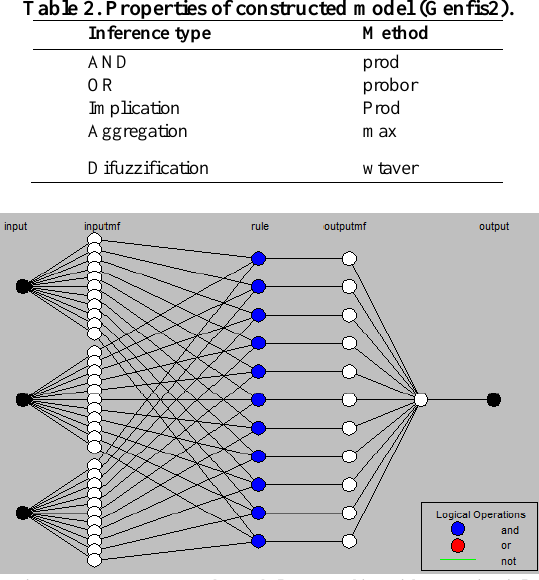
Figure 3. Constructed model to predict either uniaxial compressive strength or internal friction